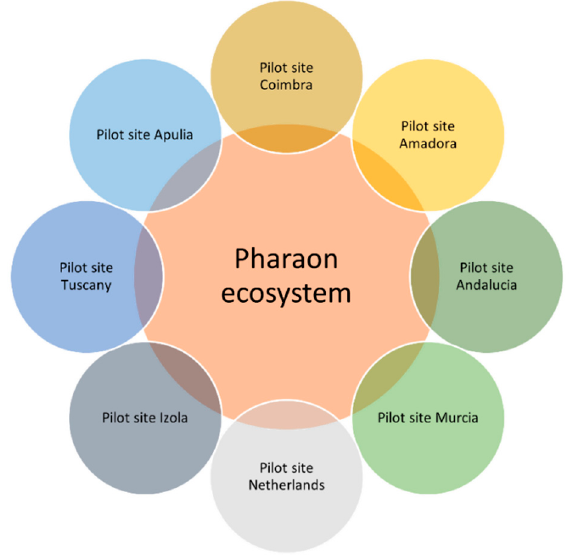
Figure 7. Pharaon ecosystem governance model.